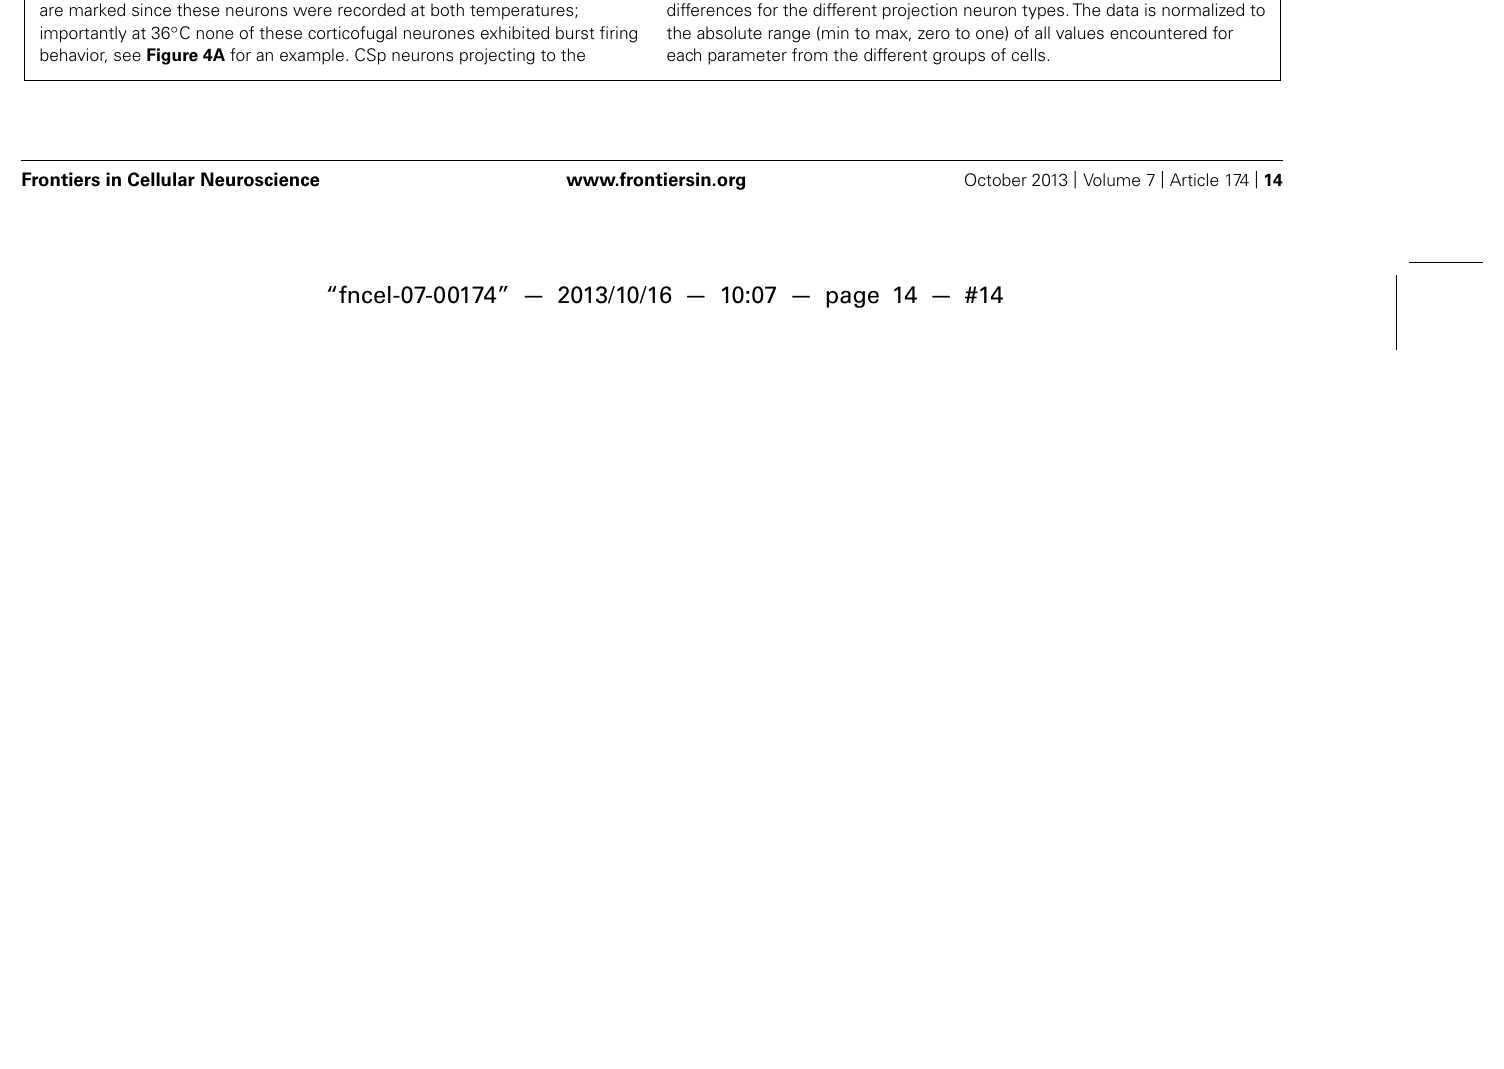
FIGURE 7 |An unsupervised cluster analysis reveals neuron grouping based on projection target. Dendrogram plots of linkage distances from an unsupervised cluster analysis of 24 parameters for all cells at 26 ◦ C (A) and 36 ◦ C (B) . Four clusters were obtained in both data sets by setting the linkage threshold to 45% of the maximum linkage distance. Neurons that exhibited burst firing episodes at 26 ◦ C are marked with a hash #, 1 × CSp neuron and 10 × CTh neurons; at 36 ◦ C the same CSp neuron and 5 of the CTh neurons are marked since these neurons were recorded at both temperatures; importantly at 36 ◦ C none of these corticofugal neurones exhibited burst firing behavior, see Figure 4A for an example. CSp neurons projecting to the